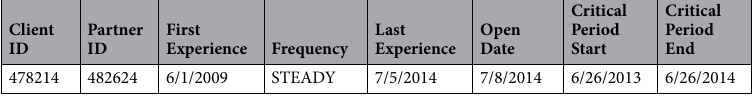
Table 1. Example of the data record format corresponding to a node pair.